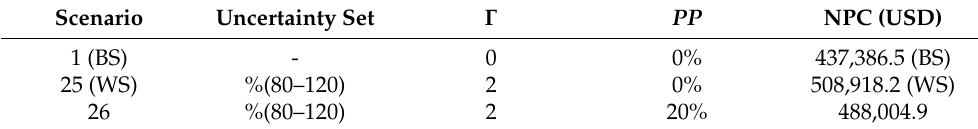
Table 5. Cost function value for different scenarios for investigating the investment cost.